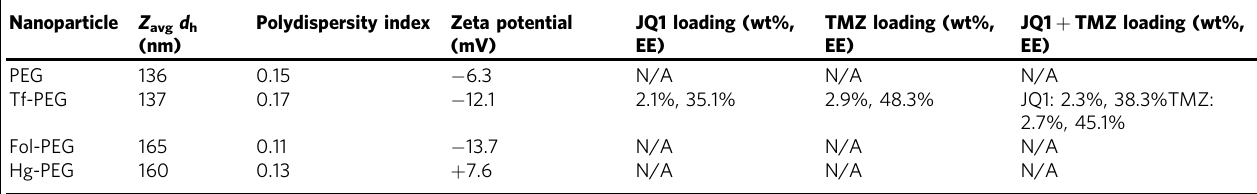
Average diameters ( Z avg d h , nm) and polydispersity indices (PDI) of PEGylated-(PEG) liposomes or liposomes functionalized with transferrin (Tf), folate (Fol), or hemagglutinin (Hg). Drug-loading properites of Tf-NPs containing either JQ1, Temozolomide, or JQ1 + Temozolomide (wt% = % of nanoparticle mass that is drug; EE encapsulation ef fi